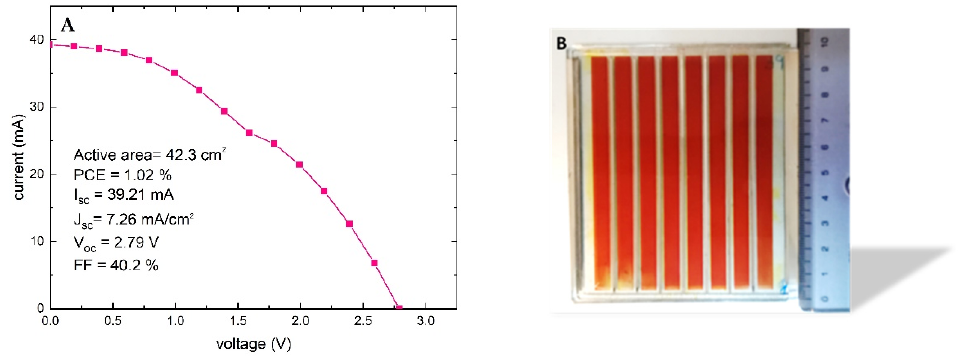
Figure 8. ( A ) I-V curve of the betalain-based DSSM. ( B ) Module sketch.